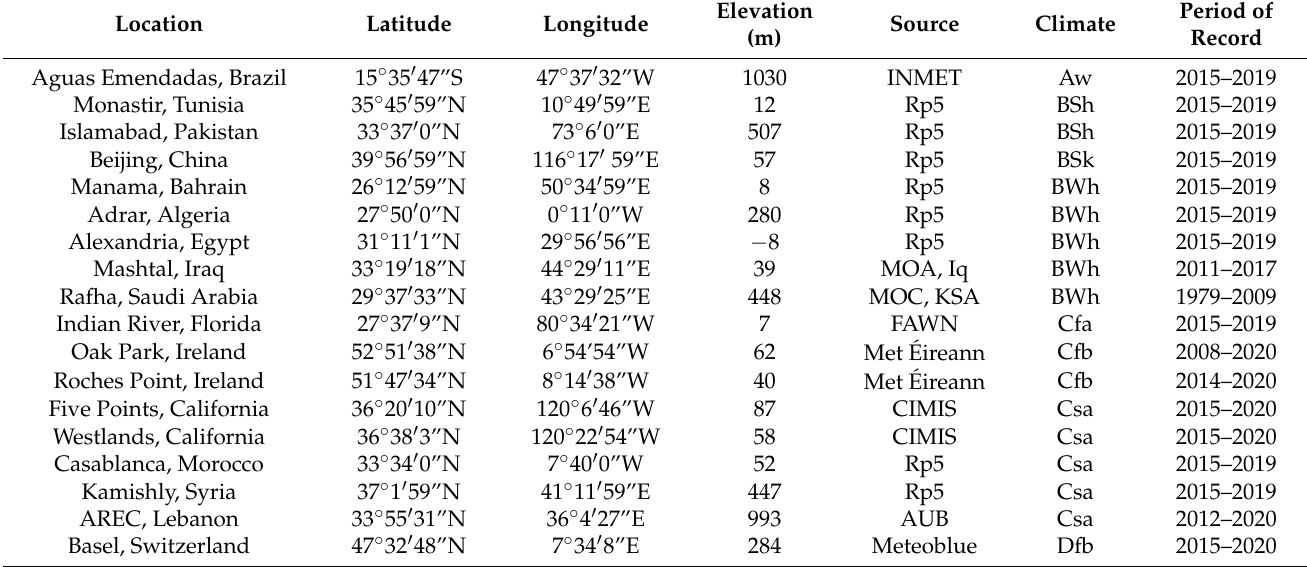
Table 3. Coordinates, altitude, elevation, wind speed height, climate, and source of studied sites.